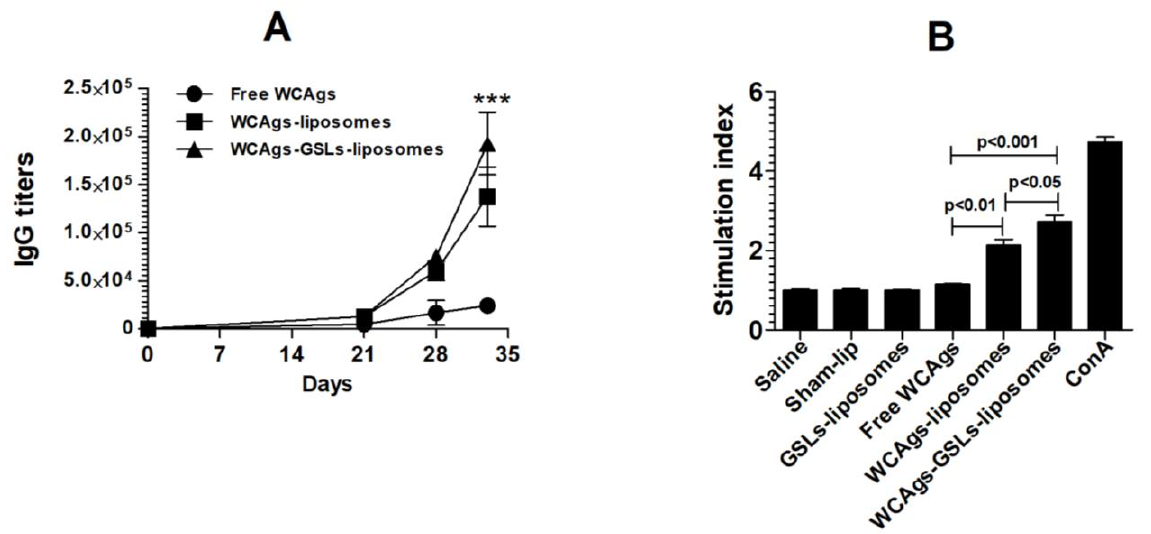
Figure 4. Mice immunized with WCAgs-GSLs-liposomes showed the highest IgG secretion and lym- phocyte proliferation. The levels of ( A ) IgG, *** ( p < 0.001) WCAgs-GSLs-liposomes vs. WCAgs- liposomes or free WCAgs ( B ) lymphocyte proliferation. The data are represented as the mean ± SD of three values.